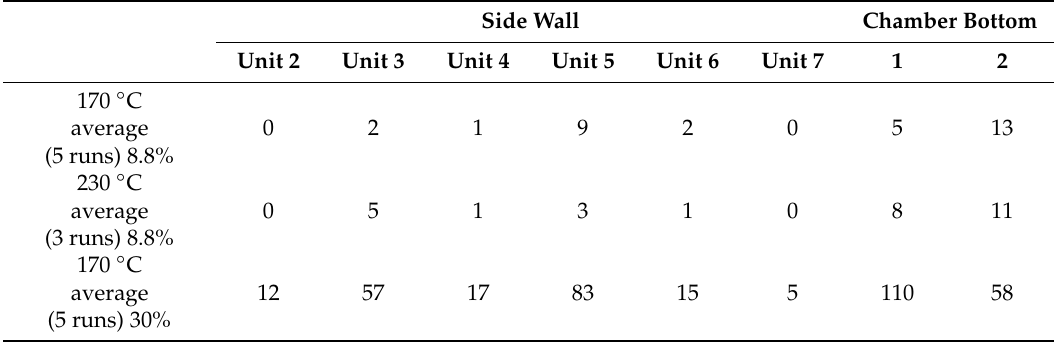
Table 4. Experimental overall values of wall deposition fluxes (kg m − 2 h − 1 ) in the four-inch design of the spray dryer.